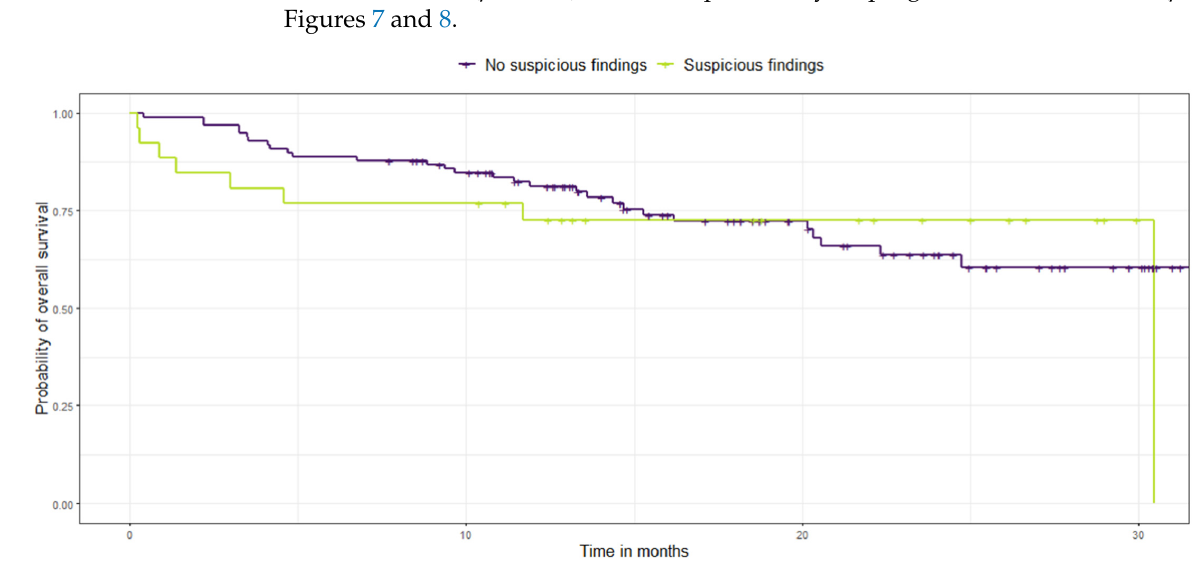
Figure 7. Kaplan-Meier survival curves display the probability of overall survival (in months) in NSCLC patients with additional suspicious findings (lemon green) versus no suspicious findings (purple).